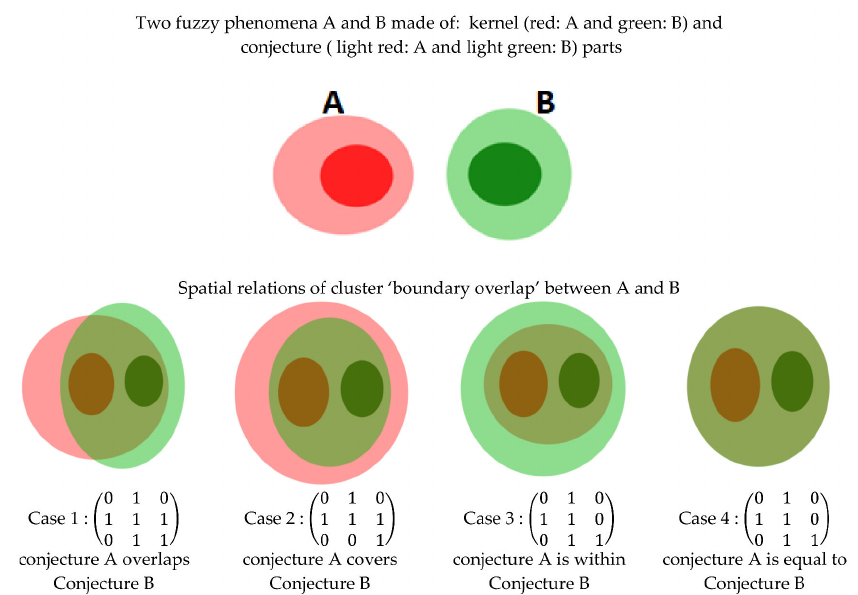
Figure 2. Cluster “boundary overlap” of spatial relations between regions with broad boundaries (conjecture part) modeled using the 9IM with poor specification on topological relations.